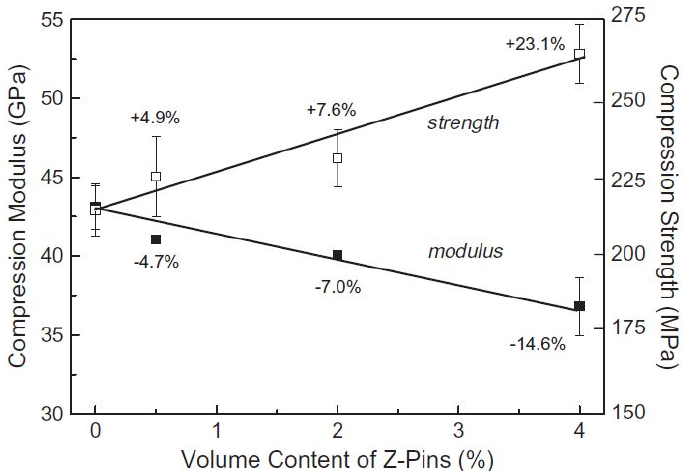
Figure 74. Effect of z-Pin content on post high energy impact (25.5J) compression modulus and strength (CFRP z-Pins, d = 0.28 mm, [0/±45/90] pre-preg) [7].